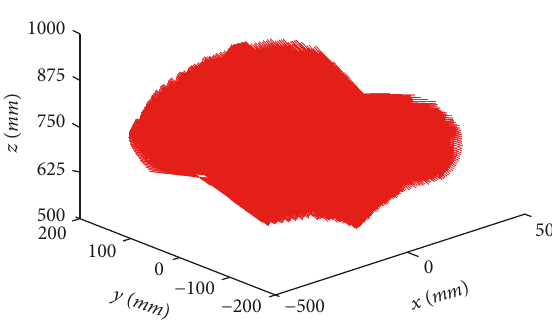
Figure 7: The entire workspace of the mechanism.